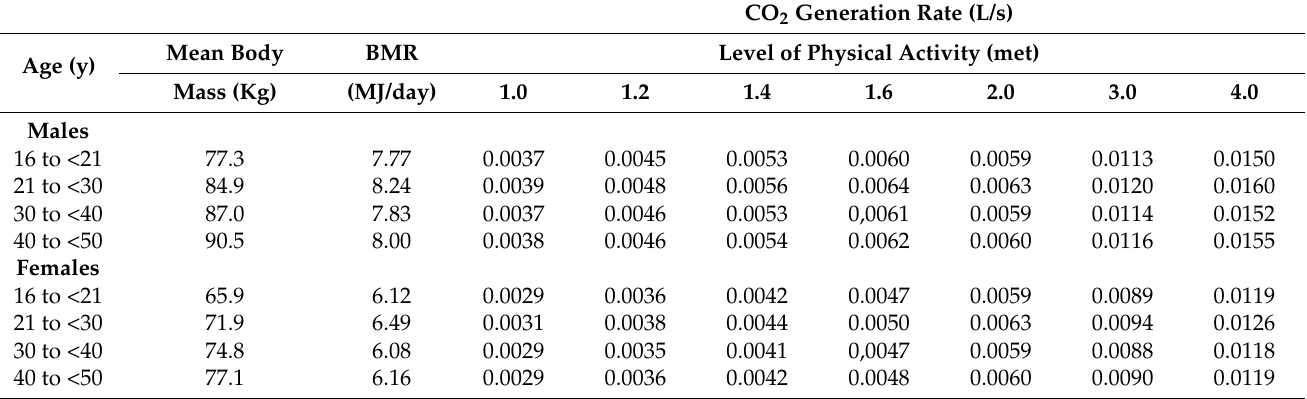
Table 11. CO 2 generation rates for ranges of ages and physical activity at 273 ◦ K and 101 KPa. CO 2 Generation Rate